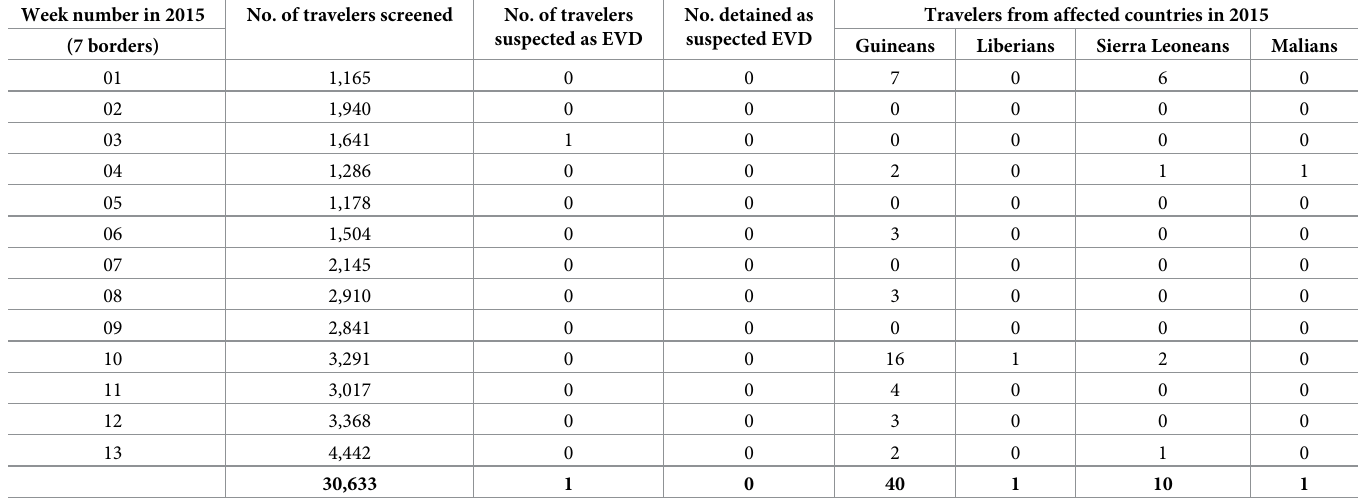
Table 2. Epidemiological weekly reports on screened travelers for EVD in Upper East Region, Ghana, 2015. Week number in